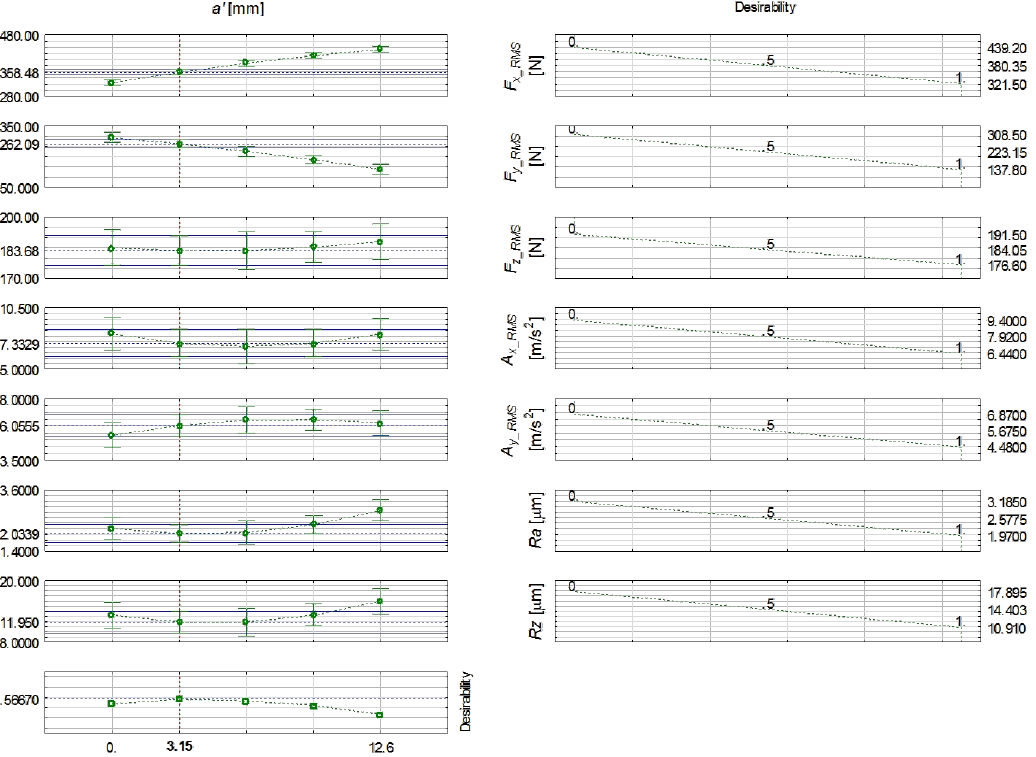
Figure 6. The partial and total desirability functions for the а factor.